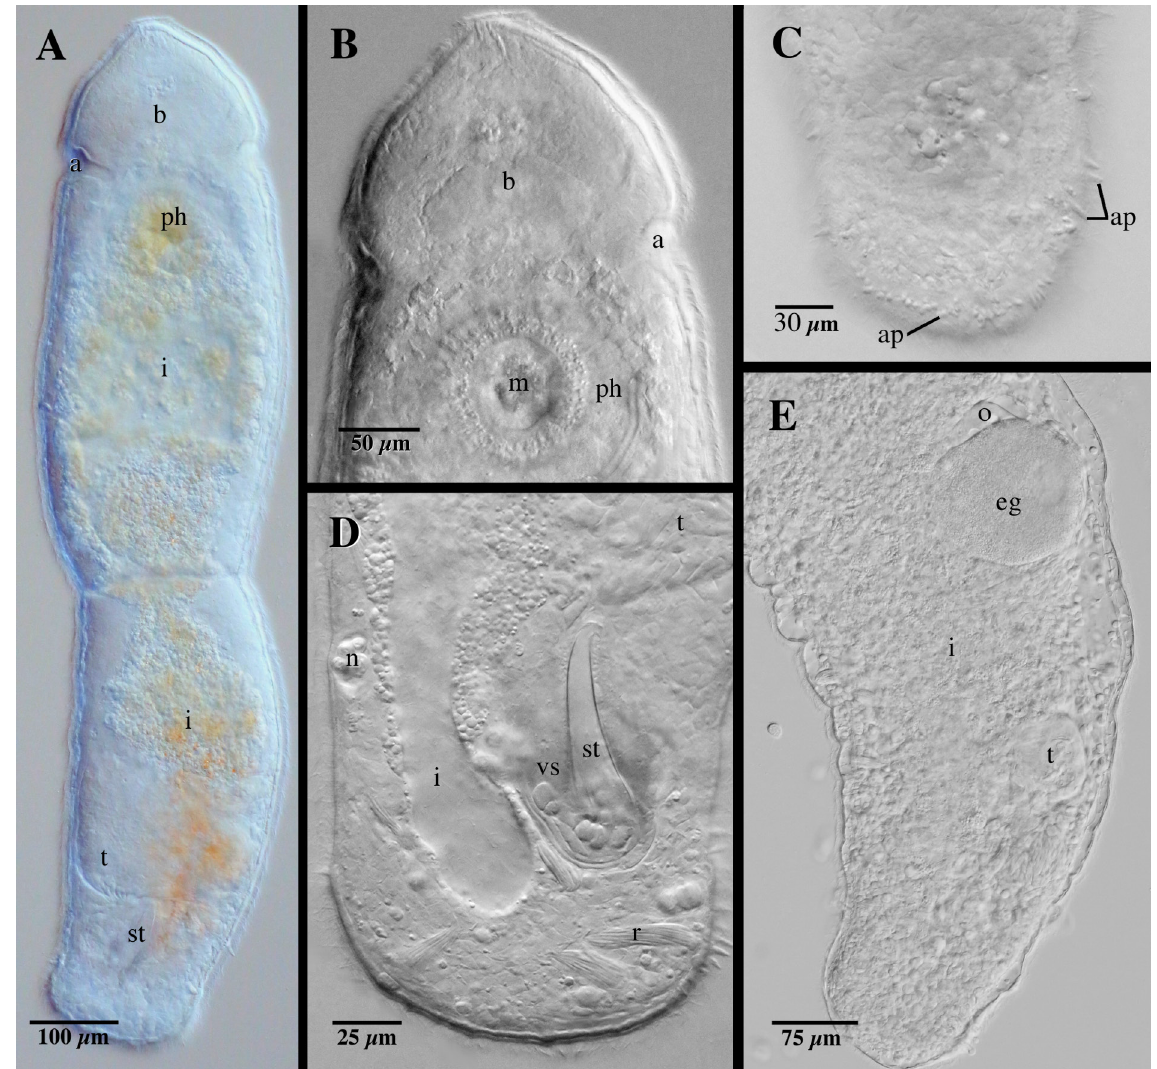
Fig. 2 . Microstomum edmondi sp. nov. A . Entire body. B . Anterior end with focus on glands around mouth. C . Posterior end with focus on adhesive papillae. D . Anterior end of male specimen. E . Anterior end of female specimen. Abbreviations: a = auricles (ciliary pits); ap = adhesive papillae; b = brain; eg = egg; i = intestine; m = mouth; o = ovary; ph = pharynx; r = rhabdite bundle; st = male stylet; t = testis; vs = vesicula